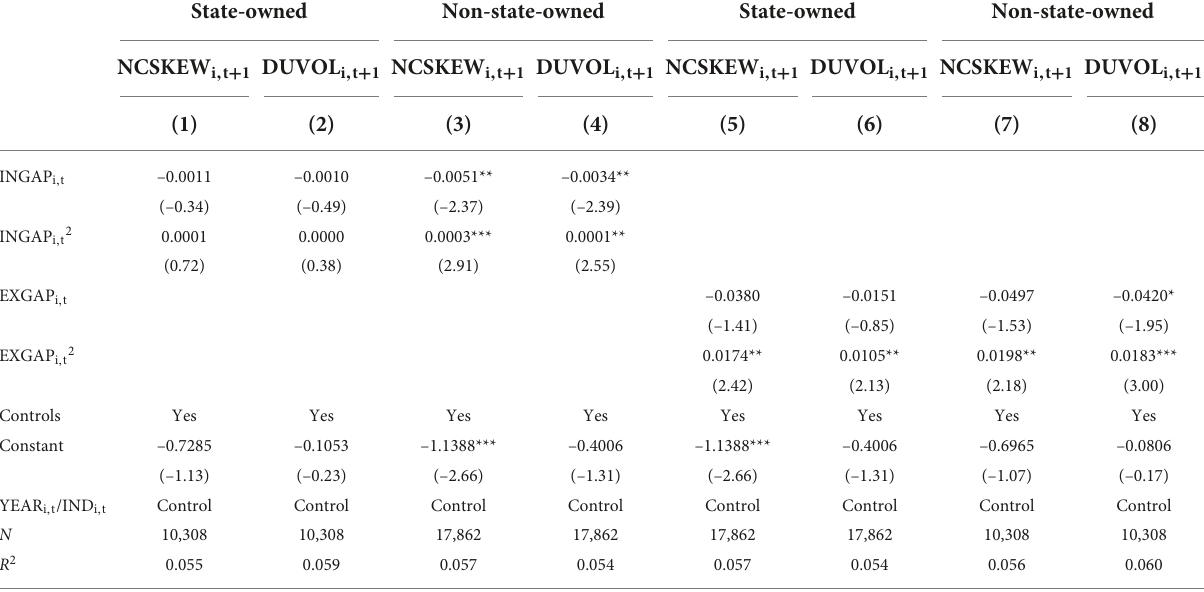
TABLE 6 The pay gap and crash risk: Effects of property right. State-owned Non-state-owned